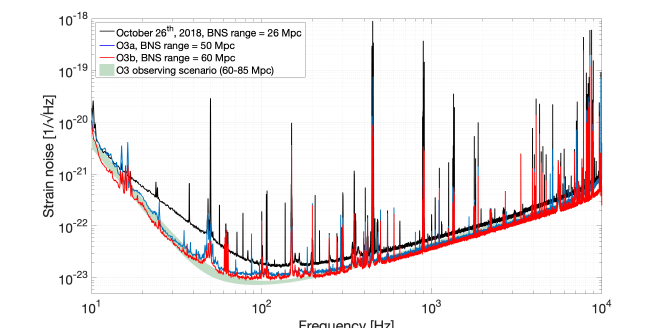
Figure 1. Amplitude spectral density of residual strain noise for Advanced Virgo in October 2018 (black), best of O3a (blue), best of O3b (red), and O3 observing scenario (green belt). The binary neutron stars (BNS) range is quoted as the average distance to which a signal generated by a BNS system with 1.4 M (cid:12) -1.4 M (cid:12) could be